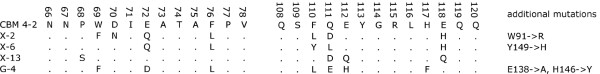
Sequence differences between the five different modules. Each protein is 165 amino acid residues long not counting the hexa-histidine tag, used in this investigation. Amino acids are represented by the standard one-letter code. Identities with the wt CBM4-2 sequence are shown by dots. Residue numbering is in accordance with Simpson et al. [25].